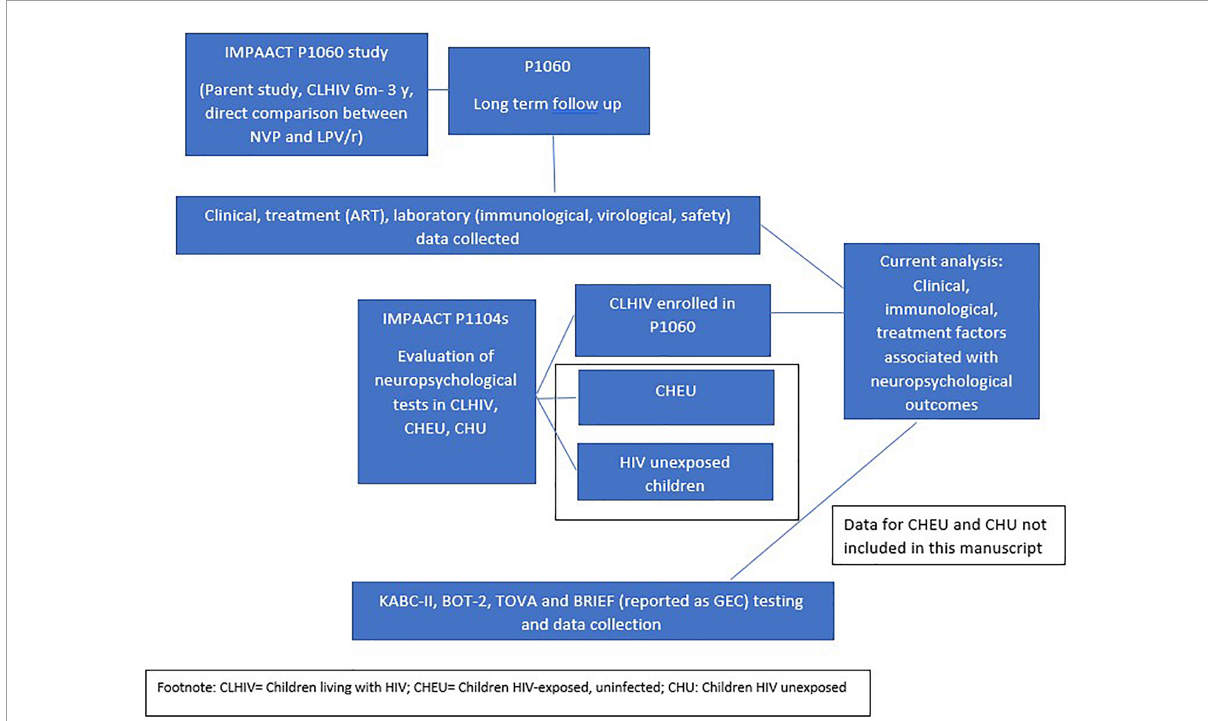
FIGURE1 Schematically presents the P1060 study and the P1104s study, demonstrating briefly what was studied in each and how data from each study was combined for analysis in the current